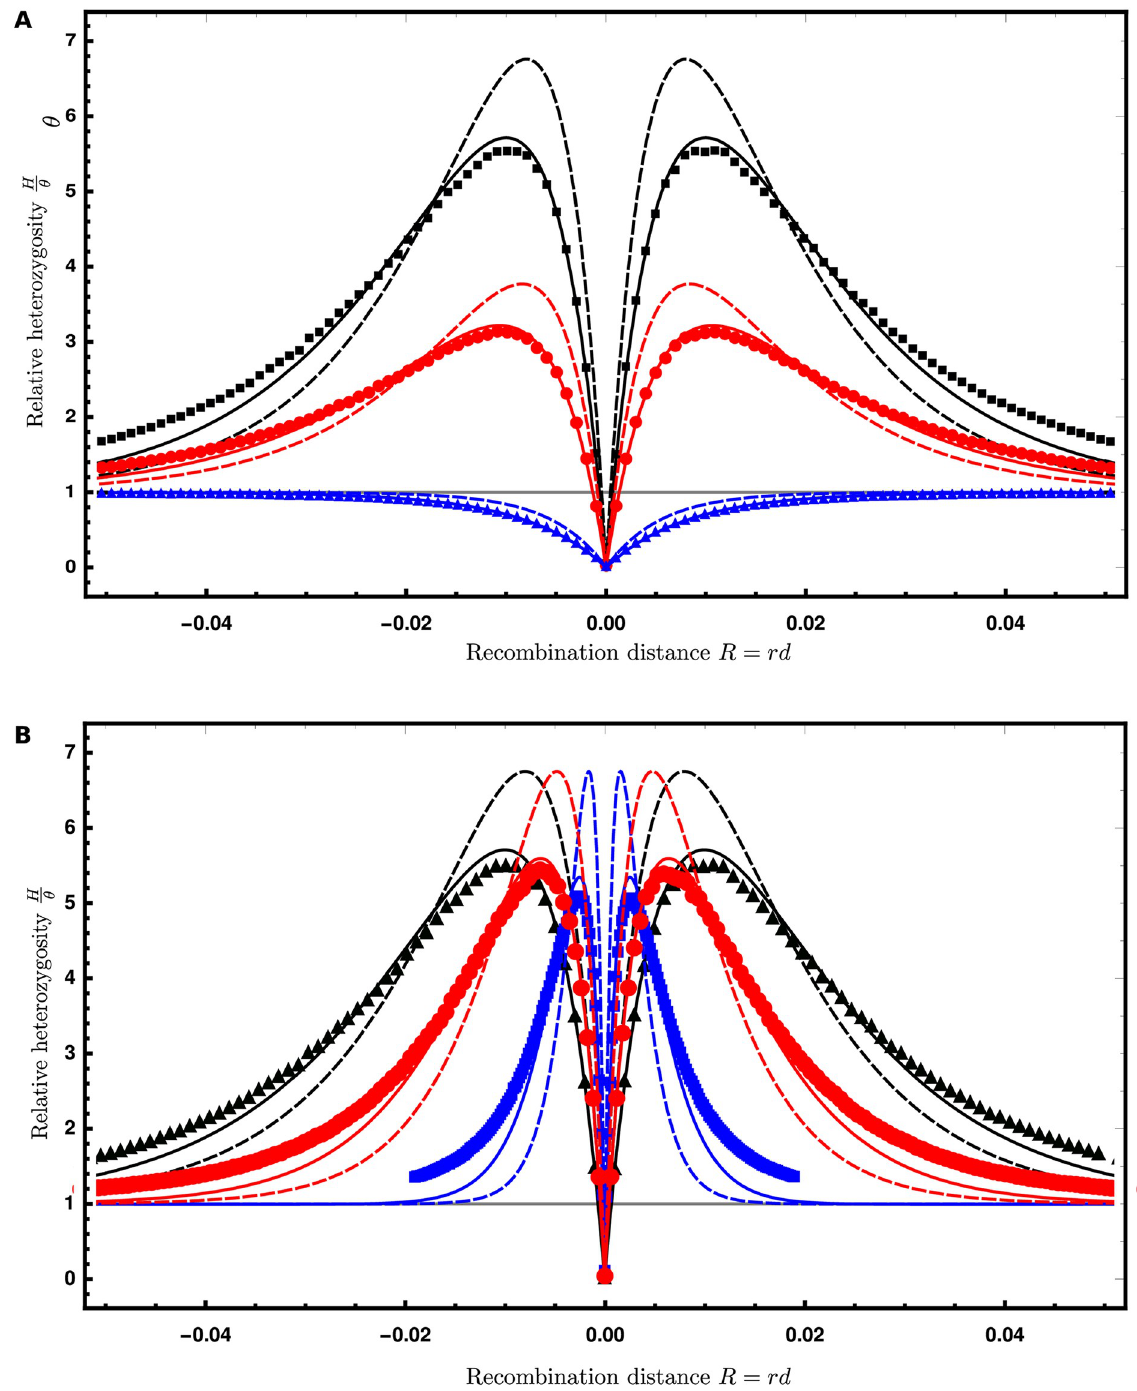
Fig 2. Volcanoes of diversity. Expected genetic diversity after the sweep relative to the initial heterozygosity, H centered at 0 as a function of the recombination distance R = rd to a neutral locus on left ( − ) and right (+) sides. For both panels, the lines show the predictions under the star-like approximation (dashed) and the better approximation (solid, see S1 Appendix, Section 1). The dots show the average ± 3 standard errors about the mean (the error bars are smaller than the plot points). A . The effect of divergence of the donor population for an introgression sweep with 2 Ns = 1000. The divergence time (in units of 4 N generations) is T ( D = 7 θ , red), and 0 ( D = θ , blue), where T d = 0 is a classic sweep from a de novo mutation. B . The effect of the strength of selection for an introgression sweep with T = 6 ( D = 13 θ ). The strength of selection is 2 Ns = 1000 (black), 600 (red), or 200 (blue). For both panels, θ = 0.002 d ( N = 5000, μ = 10 − 7 ), r = 10 − 7 , and the window size is 100 nt.